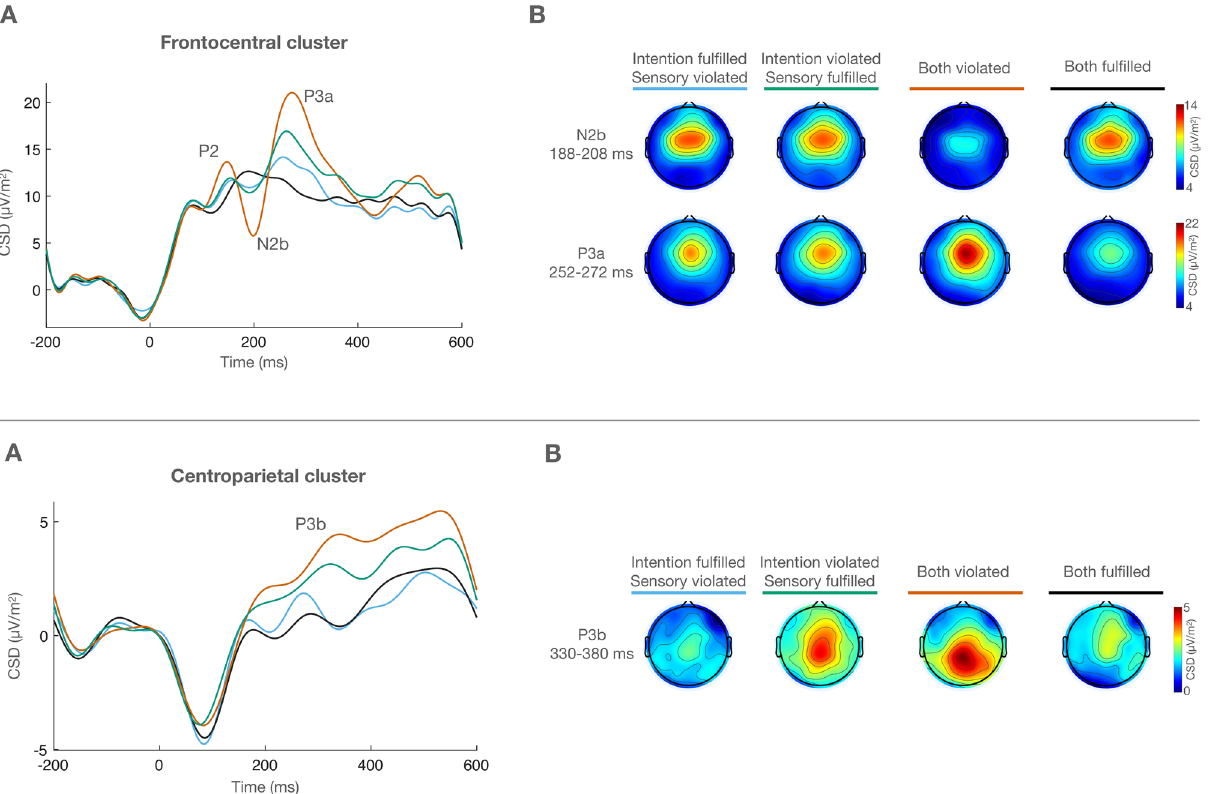
Figure 4. Upper panel ( A ) ERP waveforms corresponding to the frontocentral electrode cluster, showing P2 (between 120 and 180 ms), N2b (198 ms) and P3a (262 ms). Note that the P2 peak is delayed in the both fulfilled condition, as later confirmed by the statistical analyses. ( B ) Scalp voltage distribution maps of N2b and P3a for every condition. Lower panel ( A ) ERP waveforms corresponding to the centroparietal electrode cluster. P3b peaked at 356 ms. ( B ) P3b scalp voltage distribution maps for every